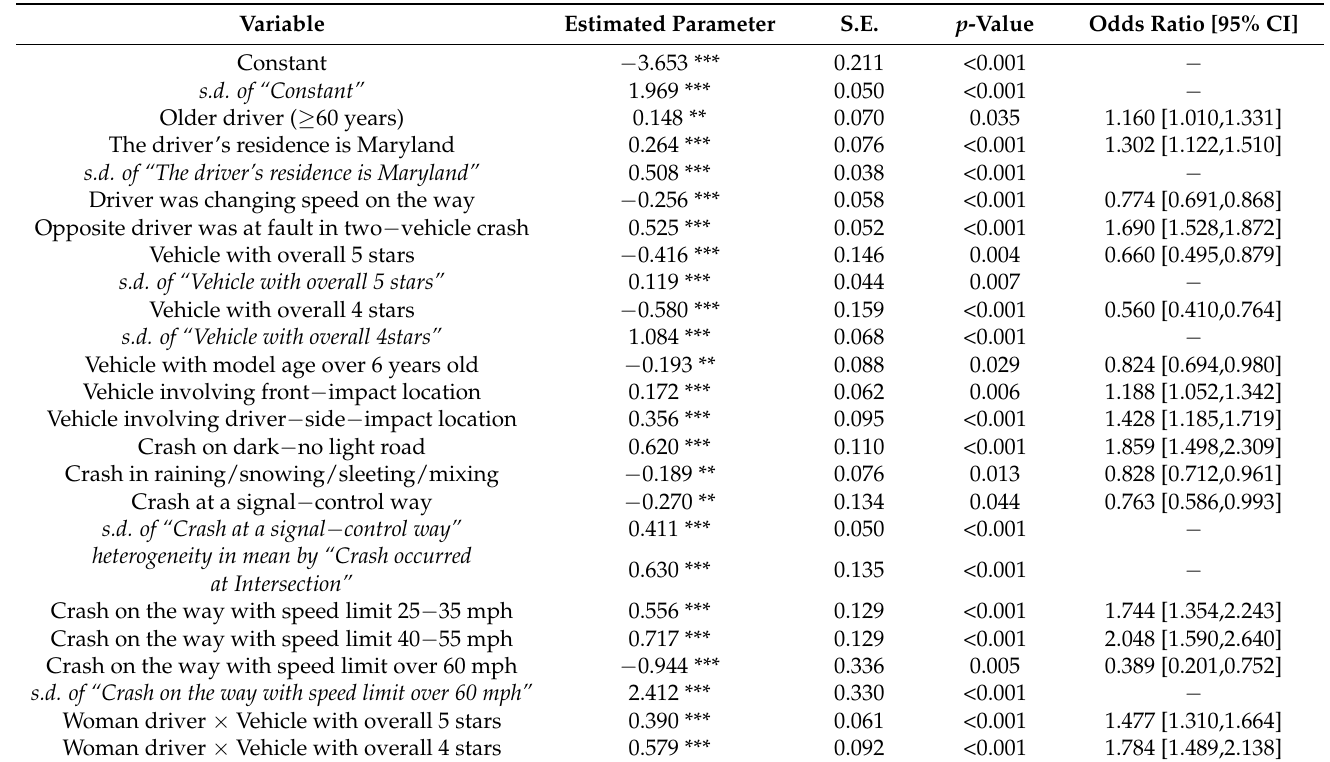
Table 3. Model results considering overall 5-star ratings of